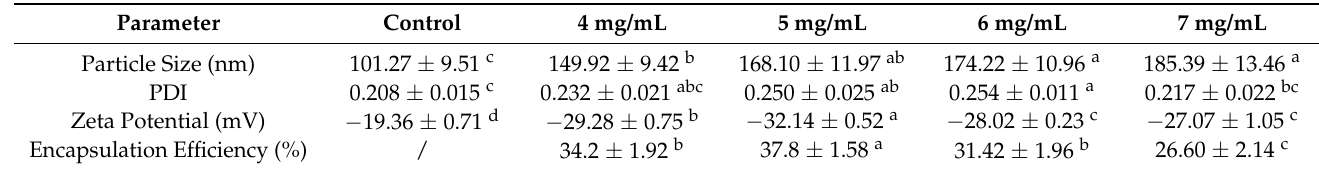
Table 1. Characterizations of nanoliposomes with LC-EO at different concentrations.